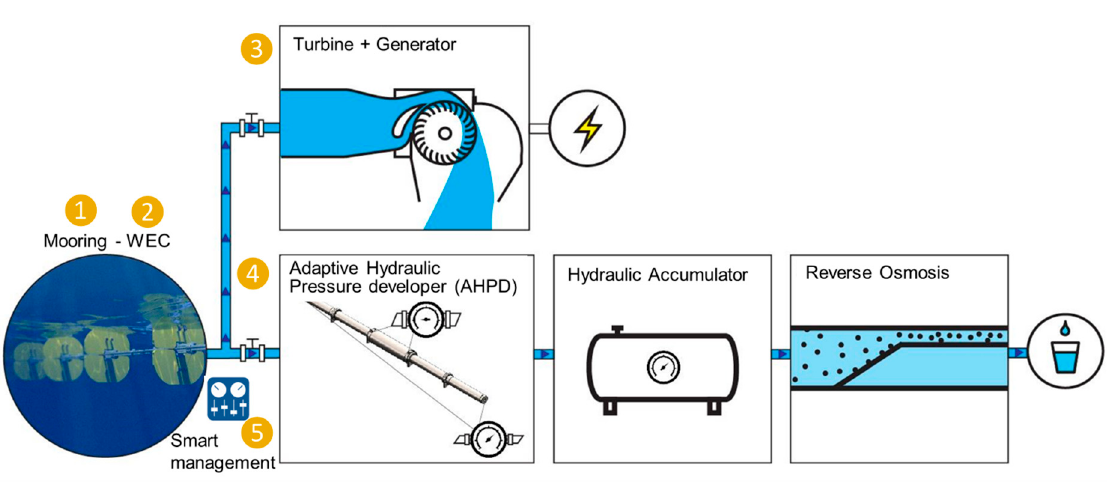
Figure 1. W2EW concept and technologies